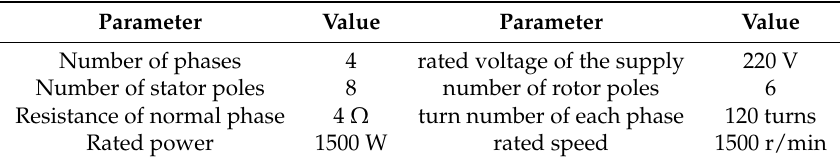
Table 3. Switched reluctance machine (SRM) characteristics.